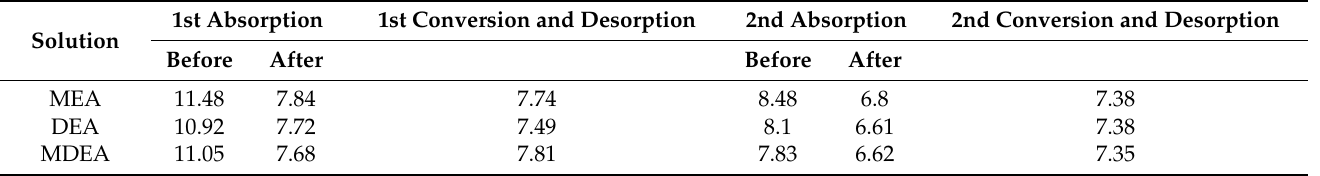
Table 4. pH changes at each step of the experiment for each amine